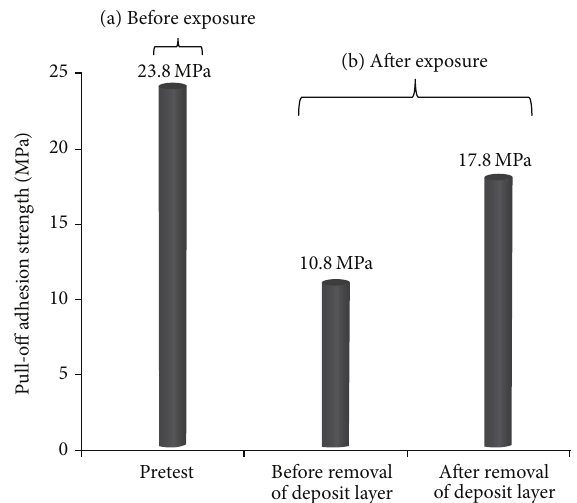
Figure 11: Pull-off adhesion strength of Fusion Bond Epoxy coating: (a) before and (b) after exposure to 5% NaOH solution for 30 days at 93 ∘ C/200 ∘ F.